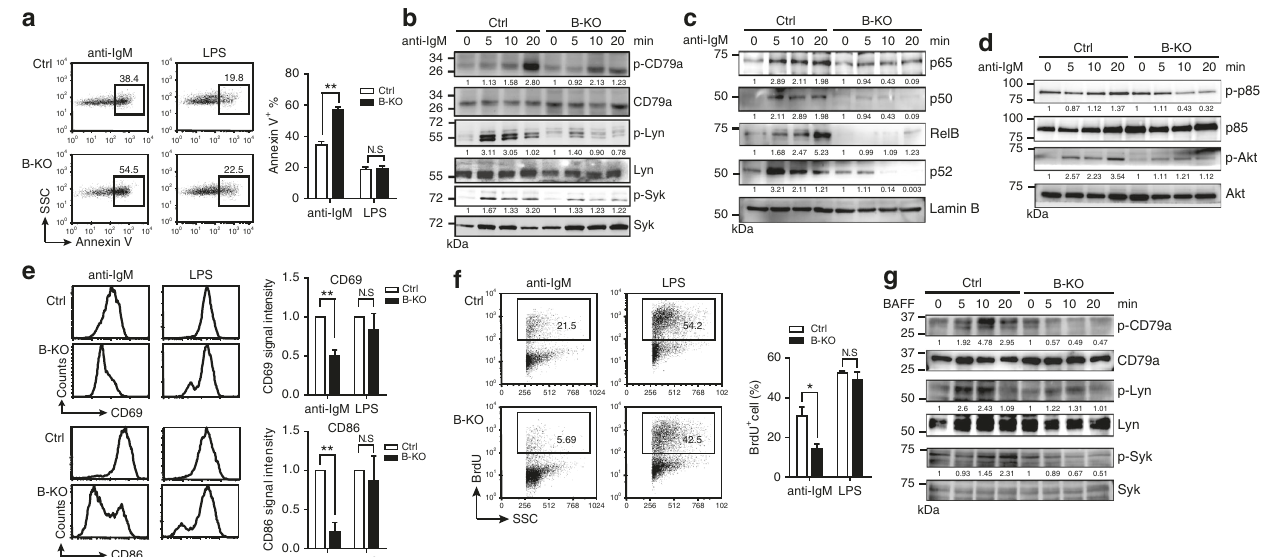
Fig. 3 Mature B cells lacking Ogt do not activate after BCR cross-linking. a Flow cytometric analysis showing the frequency of Annexin V + cells in Ctrl and B-KO splenic B cells stimulated with anti-IgM (10 µ g ml − 1 ) or LPS (2 µ g ml − 1 ) for 24 h. b Immunoblot showing the levels of CD79a, Lyn and Syk activation in Ctrl and B-KO splenic B cells after anti-IgM stimulation. c Immunoblot showing the nuclear translocation of NF- κ B subunits in Ctrl and B-KO splenic B cells after anti-IgM stimulation. Lamin B: nuclear protein loading control. d Immunoblot showing the activation of PI3K and Akt in Ctrl and B-KO splenic B cells after anti-IgM stimulation. e Flow cytometric analysis showing the levels of CD69 and CD86 in Ctrl and B-KO splenic B cells stimulated with anti-IgM or LPS for 24 h. Bar graphs on the right show the relative mean fl uorescent intensity of CD69 (top panel) or CD86 (bottom panel) normalized by that of Ctrl B cells. f Flow cytometric analysis showing the frequency of BrdU + cells in Ctrl and B-KO splenic B cells stimulated with anti-IgM or LPS for 48 h. g Immunoblot showing the phosphorylation and total levels of Lyn, Syk and CD79a after rBAFF (200 ng ml − 1 ) treatment in Ctrl and B-KO splenic B cells. The representative data from one of at least three independent experiments (two independent experiments in b ) are shown. Quanti fi cation results shown in the right panel in a , e and f are the mean ± s.e.m. ( n = 3). * P < 0.05, ** P < 0.01 (two-tailed unpaired t test). In b , c , d and g , quanti fi cation of band intensity is relative to Lamin B ( c) or each corresponding total protein ( b , d and g ) as indicated. N.S., not signi fi cell subsets in Ctrl and B-KO mice using the criteria described in Fig. 1b 21 . We found that both frequency and cell number of mature B cells, but not other stages of B cells, were largely decreased in the bone marrow of B-KO mice in comparison to Ctrl mice (Fig. 1c, d). Given that mature B cells in bone marrow are re-circulating B cells, we also examined the B-cell subsets in the spleen and found that the frequency and numbers of total B220 + B cells were decreased (Fig. 1e, f). The decreased number of splenic B cells appears to be due to the decreased number of mature B cells, particularly follicular (FO) B cells (Fig. 1e, f) but not other B-cell subsets, including immature B cells, transitional B cells (T1, T2 and T3), and marginal zone (MZ) B cells (Fig. 1f and Supplementary Fig. 2a, b).